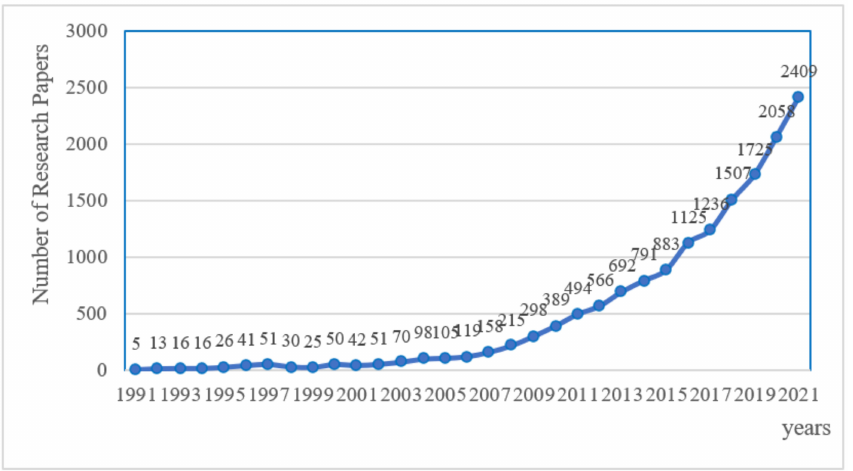
Figure 1. Annual Change Statistics on the Number of Research Papers Published in the WoSCC Database on Carbon Mitigation. Note: the data in the figure were obtained based on WOS summary and